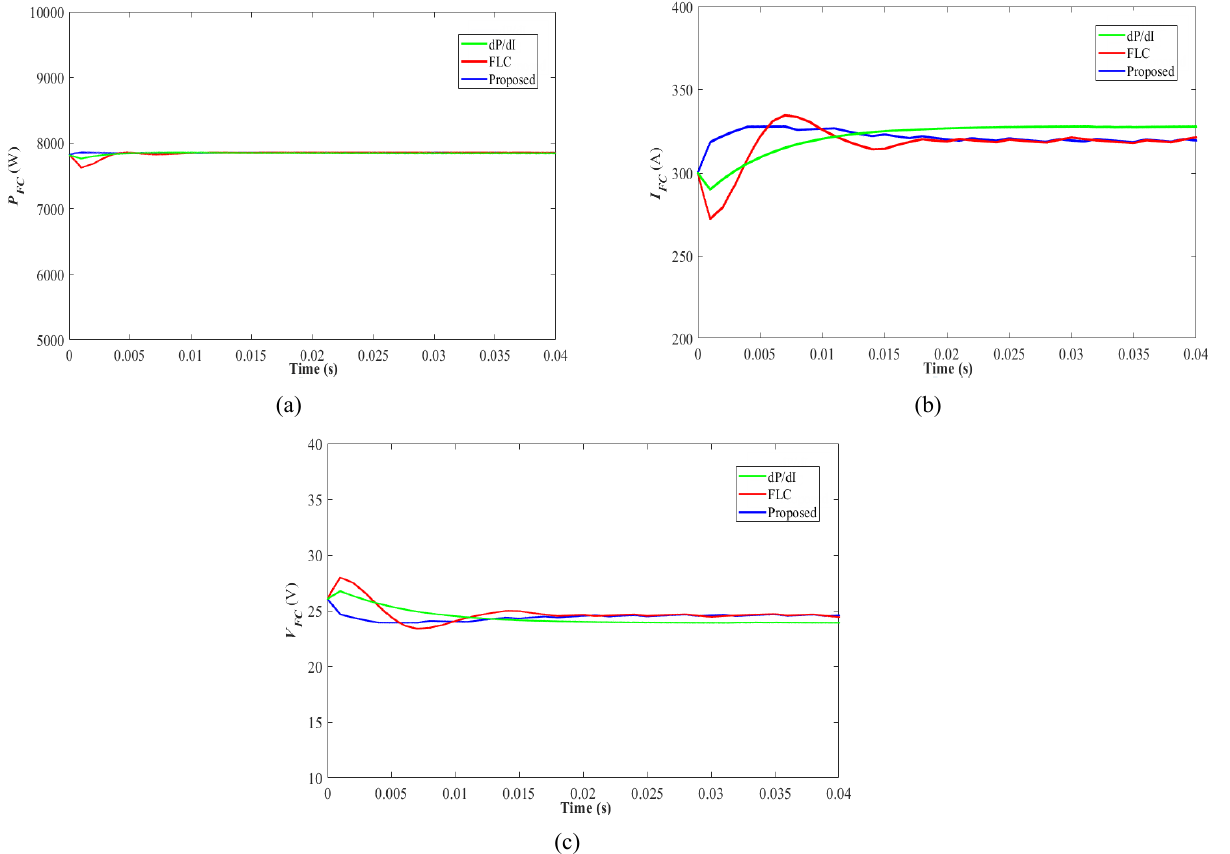
Figure 17. Results and comparisons at inrush conditions: ( a ) P FC ; ( b ) V FC ; ( c ) I FC . Table 3. Performance comparison of featured